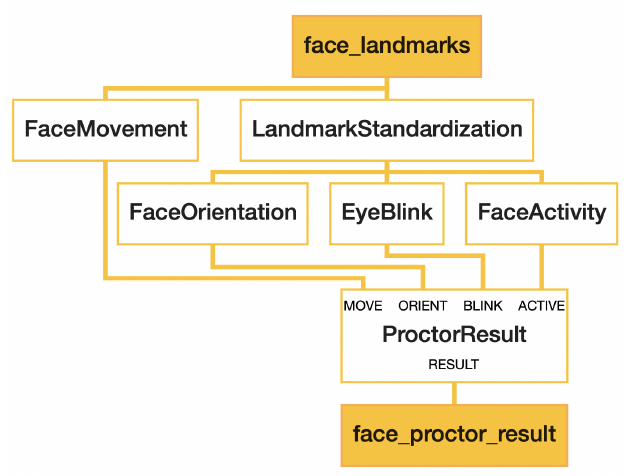
Figure 2. Overview of the